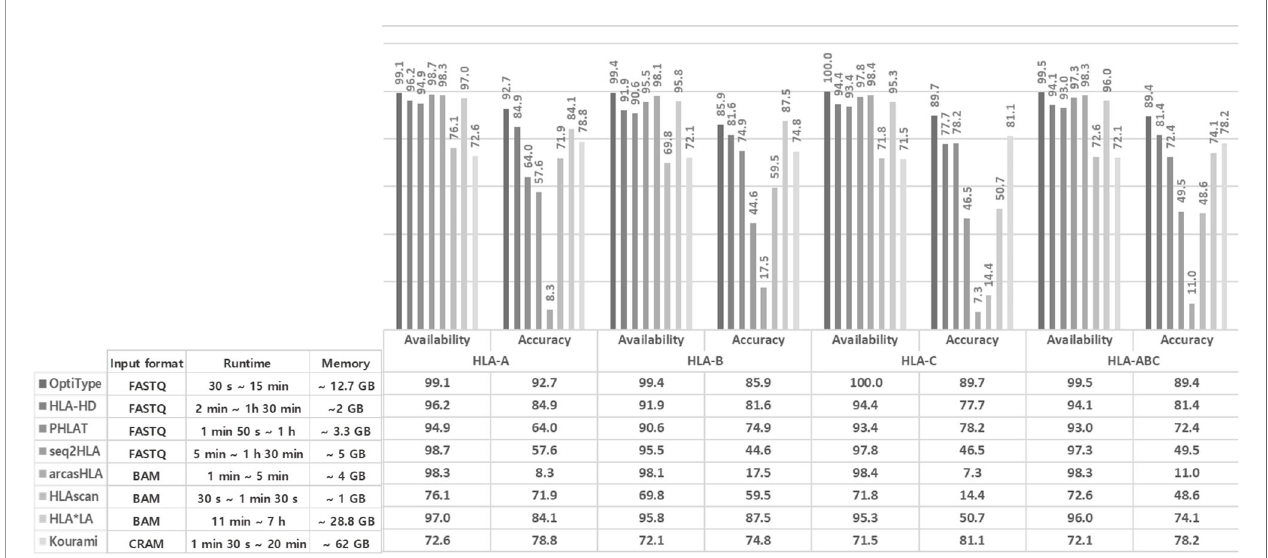
FIGURE 1 | Performance comparison of eight tools using the 1000 Genomes Project data. The availability, accuracy of the eight tools in each of HLA-A, B, and C. Availability refers to how many of the eight tools present a speci fi c call, and accuracy refers to how identical the call is comparing with 1000 Genomes Project data. Runtime and memory of the eight tools in each case. The different runtime for each tool is checked from the minimum time to the maximum time, and the maximum memory consumed is